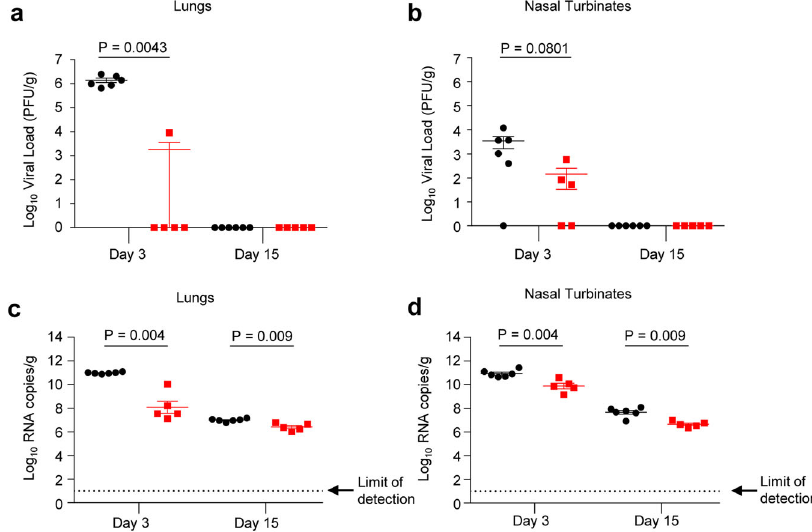
Fig. 5 SARS-CoV-2 tissue viral load in hamsters. Hamsters were challenged intranasally with 10 5 PFU SARS-CoV-2 and half of the animals in each group were euthanized at days three and 15 post challenge. Right lungs ( a , c ) and nasal turbinates ( b , d ) from each animal were homogenized in media, and viral loads were determined by plaque assays on Vero E6 cells ( a , b ) or by qRT-PCR ( c , d ). The limit of detection for the plaque assay was 70 PFU per lung and 35 PFU per nasal turbinate. The limit of detection for the qRT-PCR assay is indicated by the dotted line. The ConVac vaccine group is shown in red and the control group in black. For each timepoint, N = 6 for control group and N = 5 for ConVac vaccine group. Mean values ± SEM. P values determined by Mann – Whitney